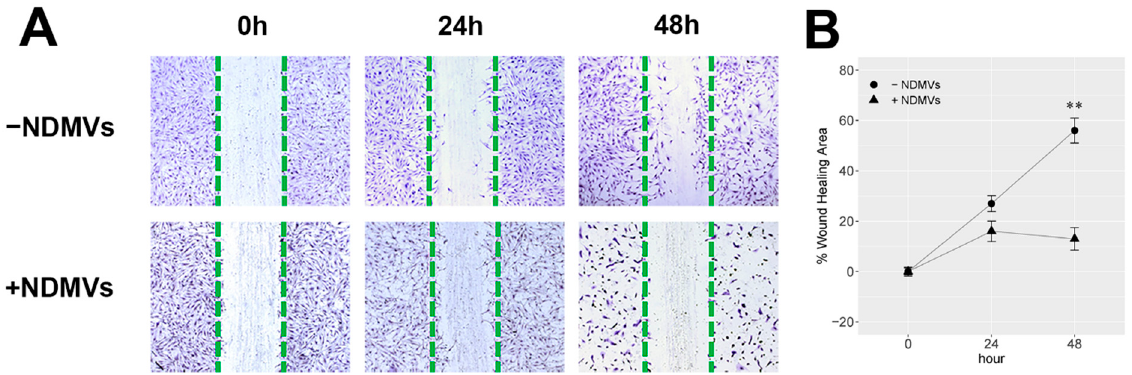
Figure 4. Would healing assay (WHA) for FLS with or without NDMV treatment. ( A ) Images of FLS monolayer scratching with and without NDMVs at 0, 24 and 48 h; ( B ) WHA of FLS incubated in the absence ( ● ) or presence ( ▲ ) of NDMVs at a ratio of 100 over 0, 24 and 48 h incubation periods. WHA percentage was quantified by the ImageJ software. Data were analyzed with the Wilcoxon test compared to the non-NDMV-treated group. Values shown are mean (±SE, n = 5). ** p < 0.01.